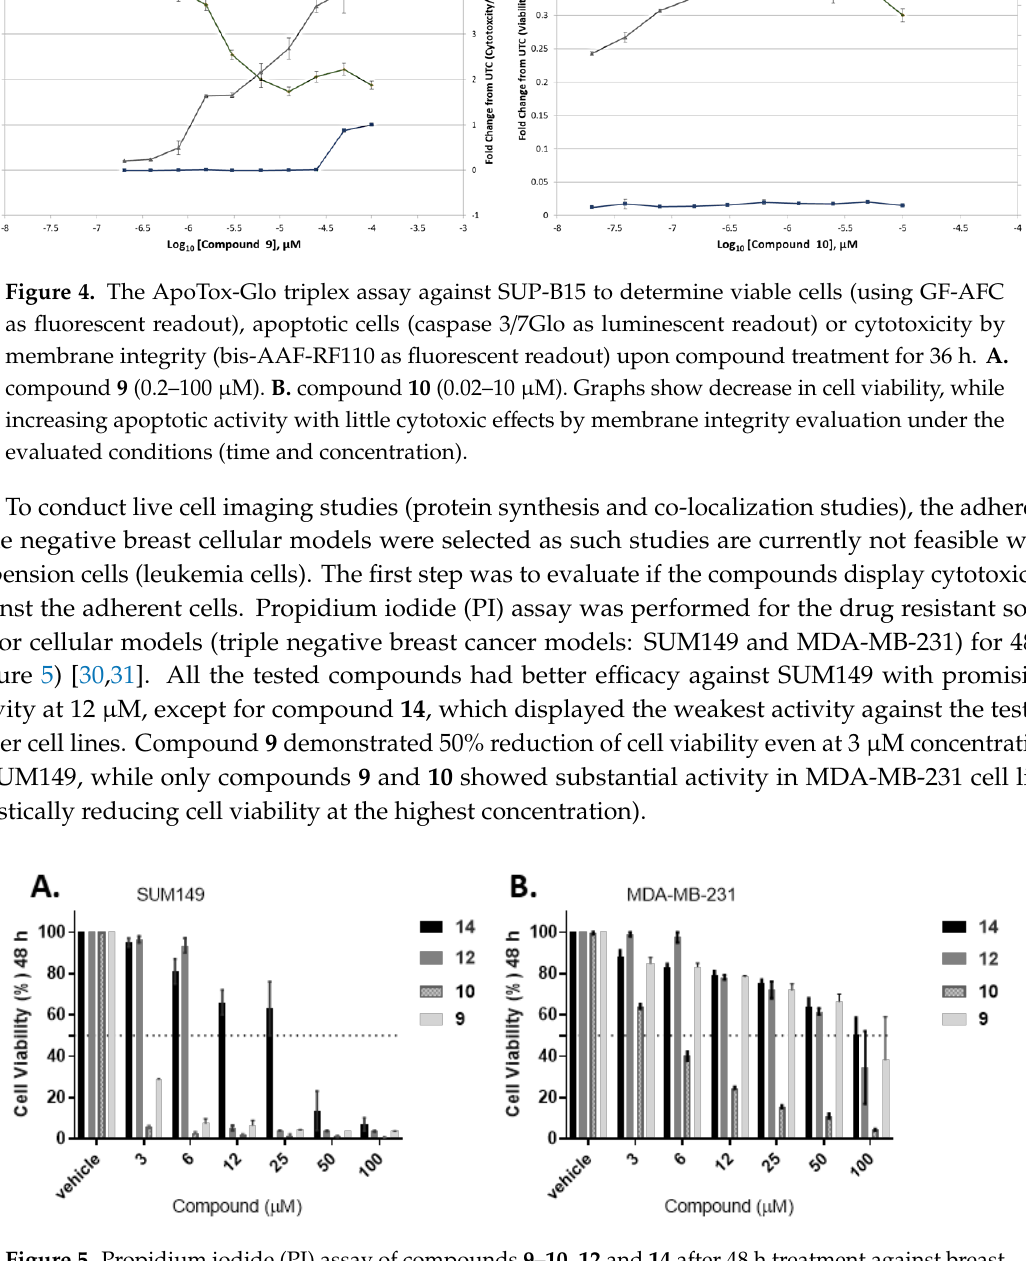
Figure 5. Propidium iodide (PI) assay of compounds 9 – 10 , 12 and 14 after 48 h treatment against breast cancer cell models to determine apoptotic effects. A. SUM-149, and B. MDA-MB-231. Bars represent mean ± SEM of at least three biological